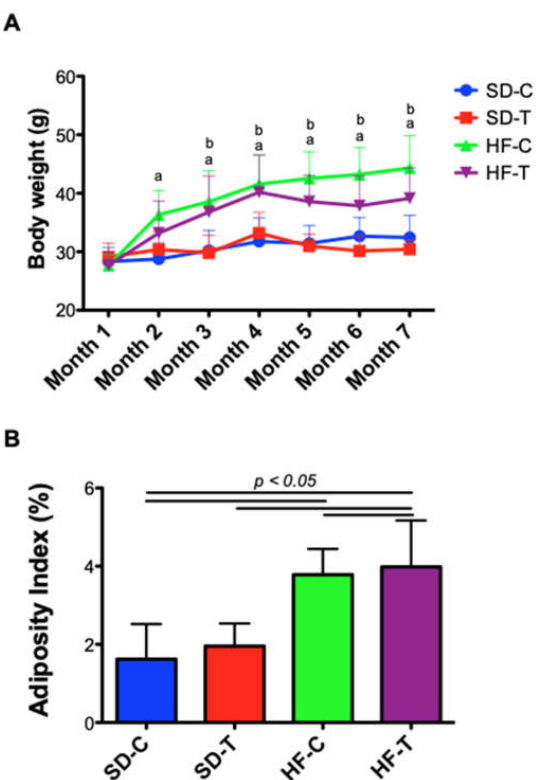
Figure 2. Effects of diets and exercise on body weight and adiposity index. ( A ) Two-way ANOVA was used to verify differences of body weight over eight weeks. The “a” means difference between control groups (SD-C vs HF-C) at the same time. The “b” indicates differences between the trained groups (SD-T vs HF-T). There was interaction between “diet x exercise”, p < 0.001, F = 3.31. ( B ) Significant differences between control groups compared to exercise groups ( p < 0.05, represented as a line).